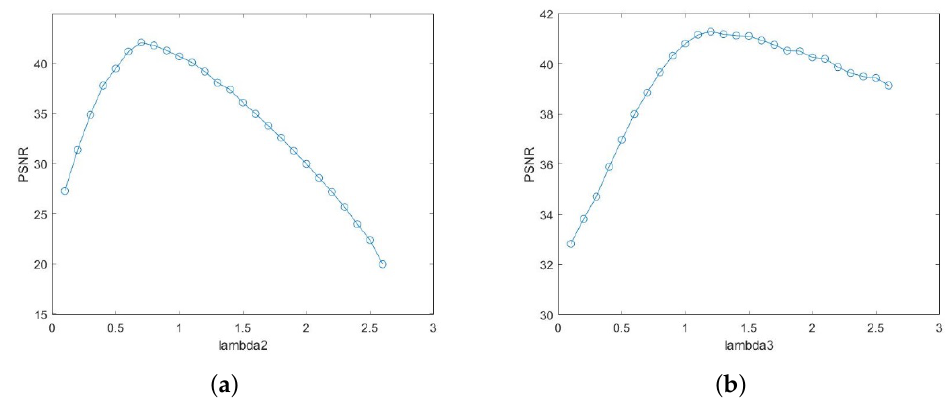
Figure 5. Influence of regular terms on the PSNR: ( a ) relationship between λ 2 and PSNR; ( b ) relationship between λ 3 and PSNR.